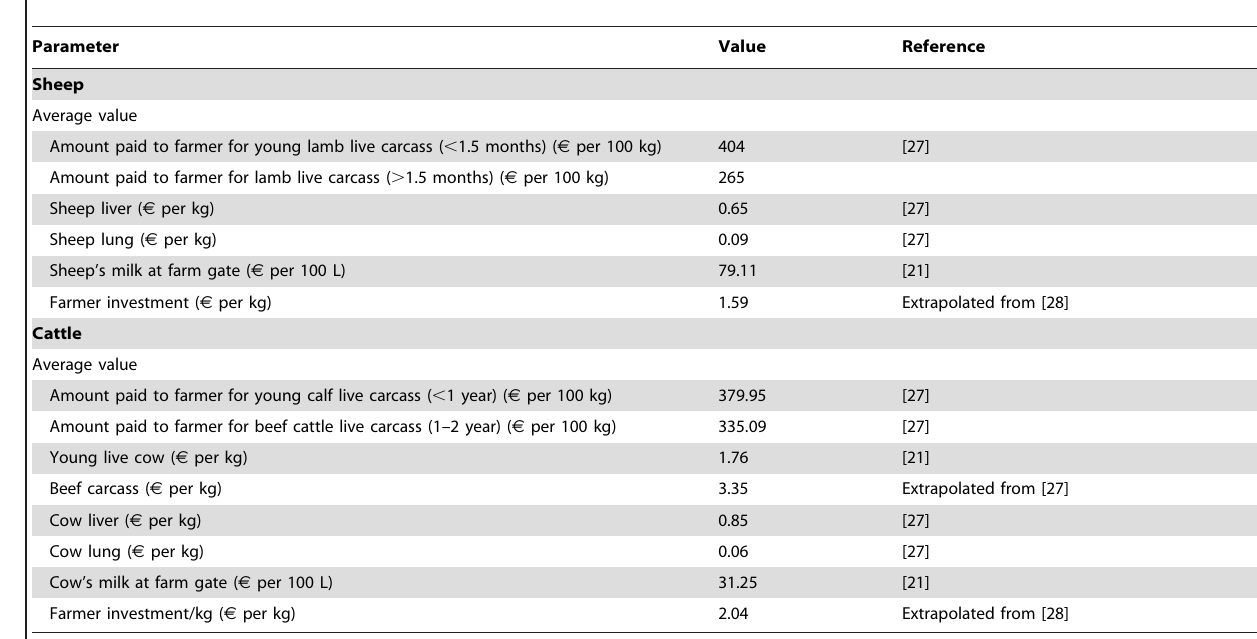
Table 5. Cost parameters used to estimate the economic losses associated with CE in sheep and cattle, A´lava, 2005.